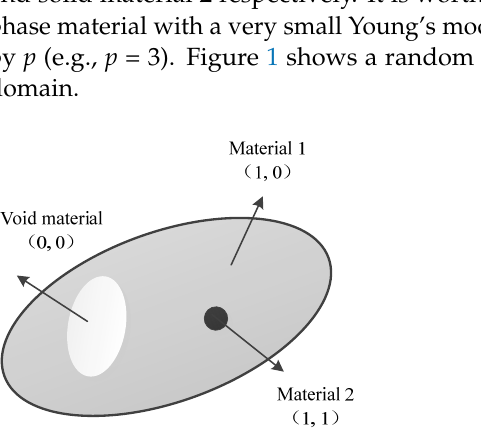
Figure 1. A random distribution of multi-material in the design domain.